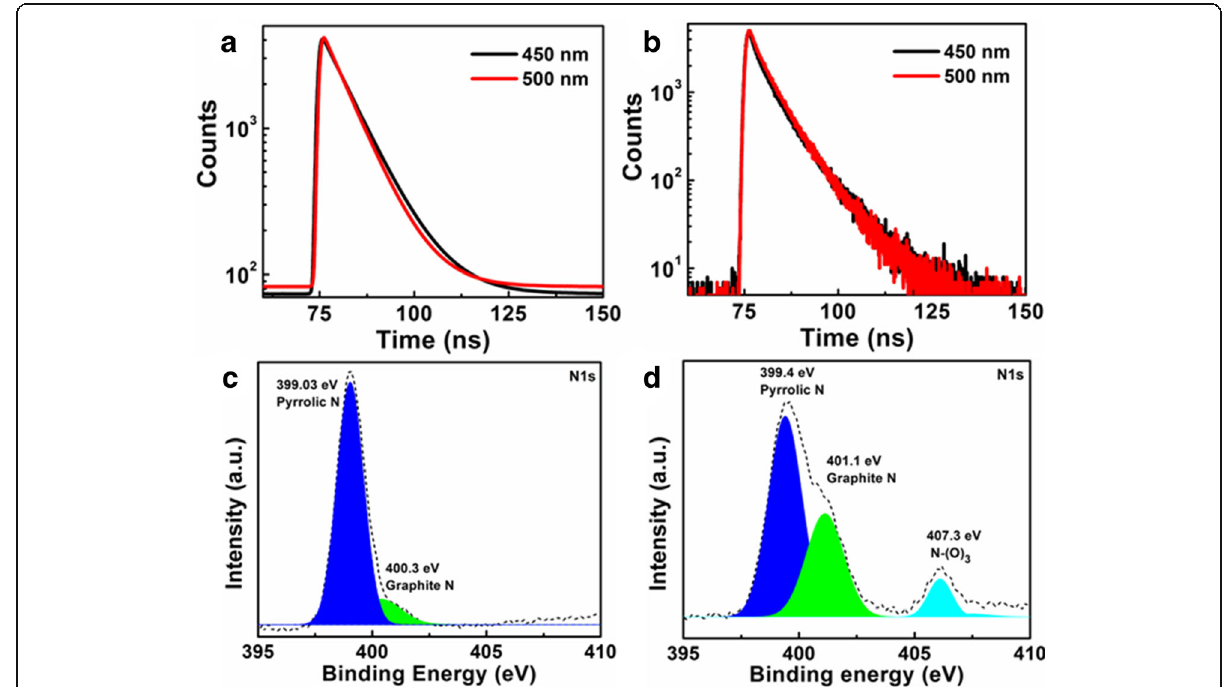
Fig. 2 a , b Fluorescence decay of CDs before ( a ) and after ( b ) adding 0.5 M H 2 O 2 . c , d XPS (N1s) of CDs before ( c ) and after ( d ) adding 0.5 M